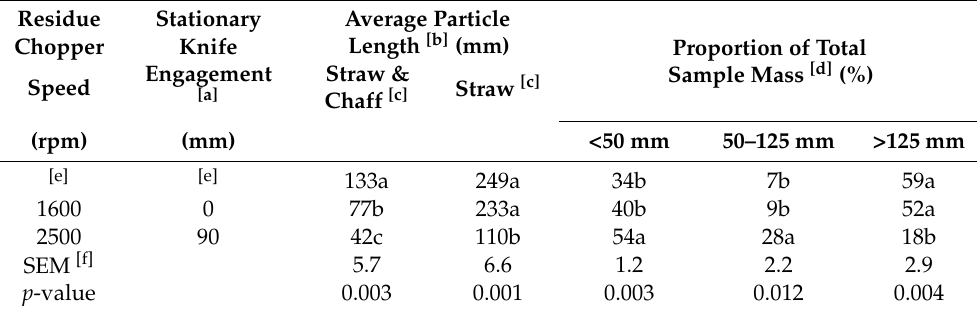
Table 4. Summary of particle-size distribution and length from Experiment 2 using various combine residue chopper